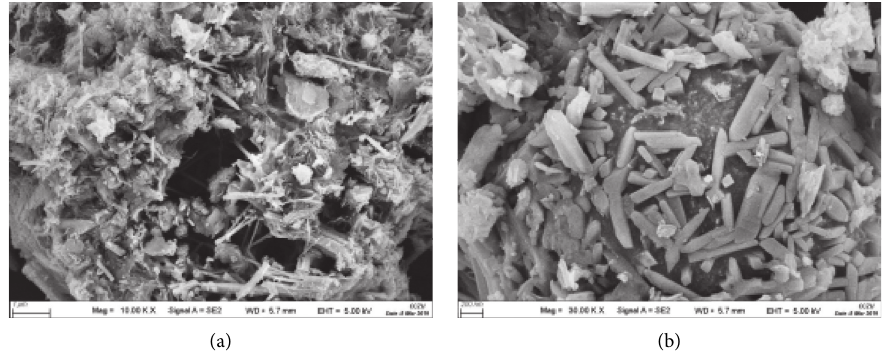
Figure 9: SEM photograph of (a) sample surface and (b) sample